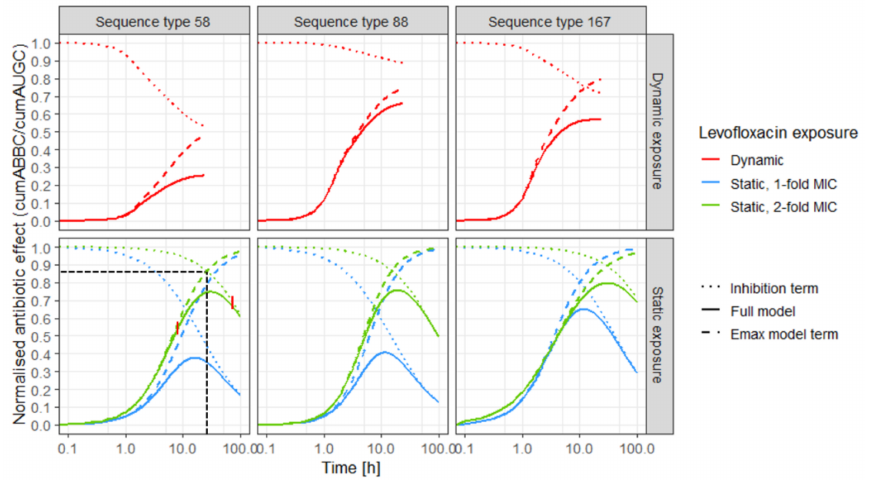
Figure 3. Predicted effect (solid lines) of levofloxacin over time against three Escherichia coli isolates (left: sequence type 58, middle: sequence type 88, right: sequence type 167) in in vitro infection model experiments, based on the E max model with inhibition term; and predictions based only on the separate inhibition term (regrowth process, dashed lines) and only on the E max model term (killing process, dotted lines); upper panel: predictions for dynamic exposure (red); lower panel: predictions for static exposure to 1-fold MIC (blue) and 2-fold MIC (green), black horizontal and vertical dashed lines indicate the intersection between killing and regrowth trajectories, exemplified for sequence type 58, static 2-fold exposure; vertical red lines indicate three phases of exposure–effect relationship: “killing phase”, “transition phase” and “ regrowth phase”; MIC: minimal inhibitory